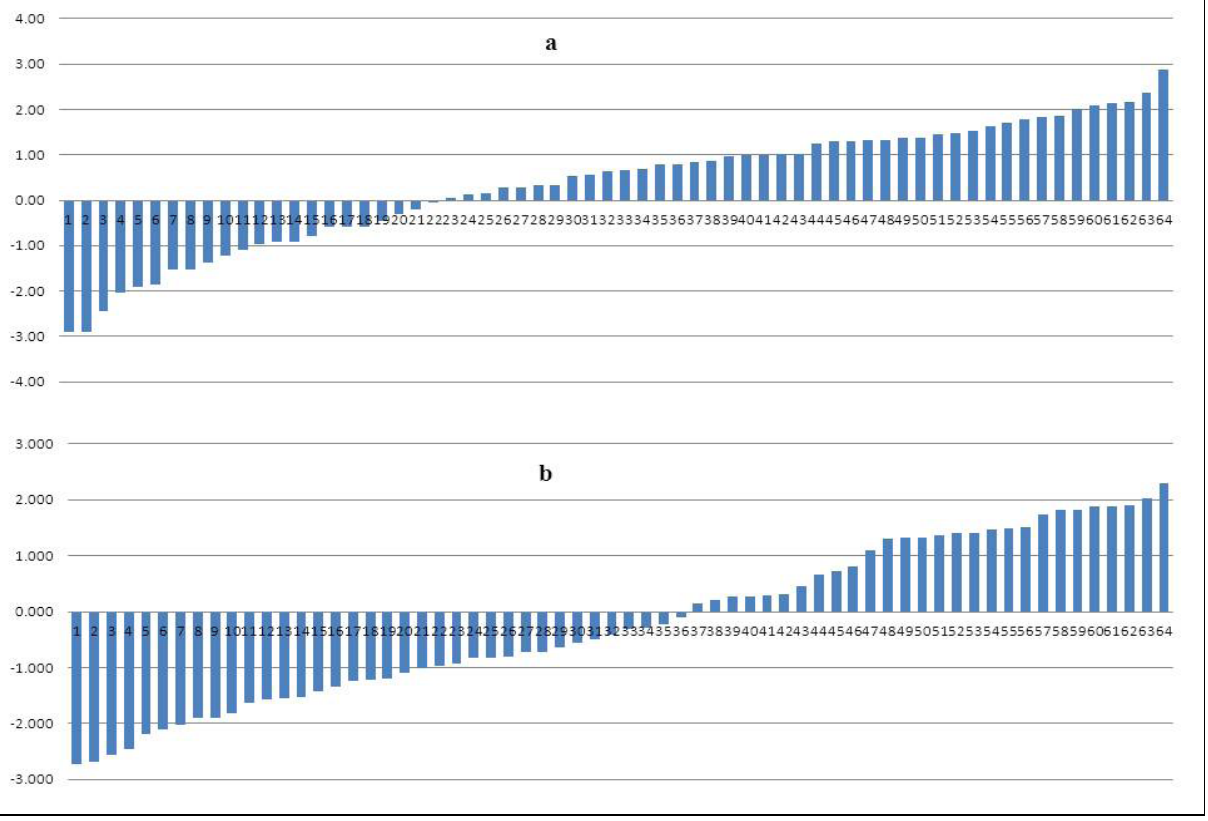
Figure 5. Differences between measured and predicted arch width values (mm) of maxillary intercanine width: (a) females, (b)